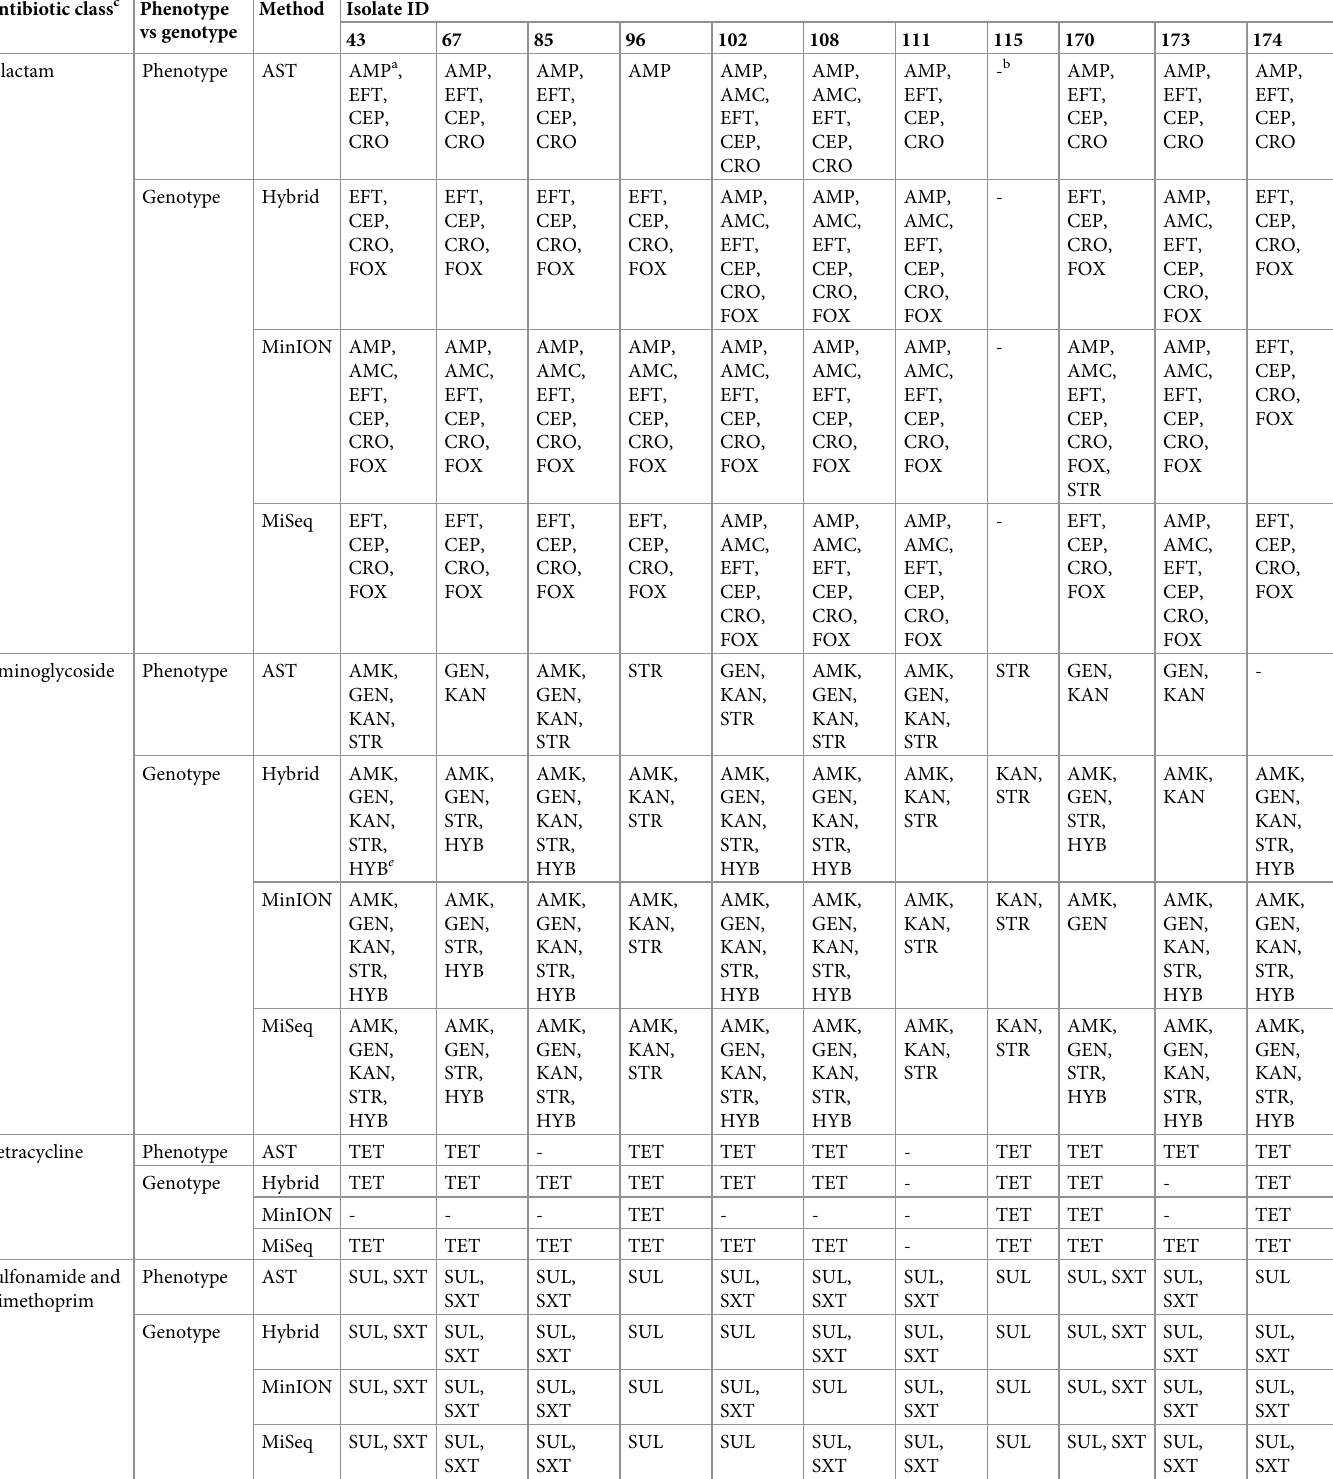
Table 2. Antimicrobial resistance (AMR) phenotypes of S . Indiana isolates, and their corresponding AMR genotypes, as predicted based on their hybrid, MinION, and MiSeq